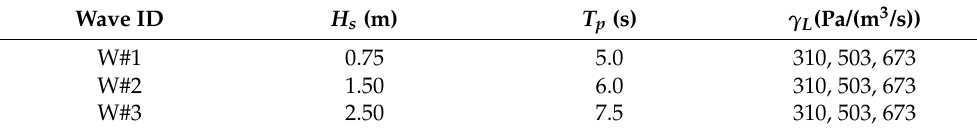
Table 1. Simulation conditions of irregular wave conditions and linear pressure drop coefficients for comparison of hydrodynamic energy conversion responses between the LDM and DIM.